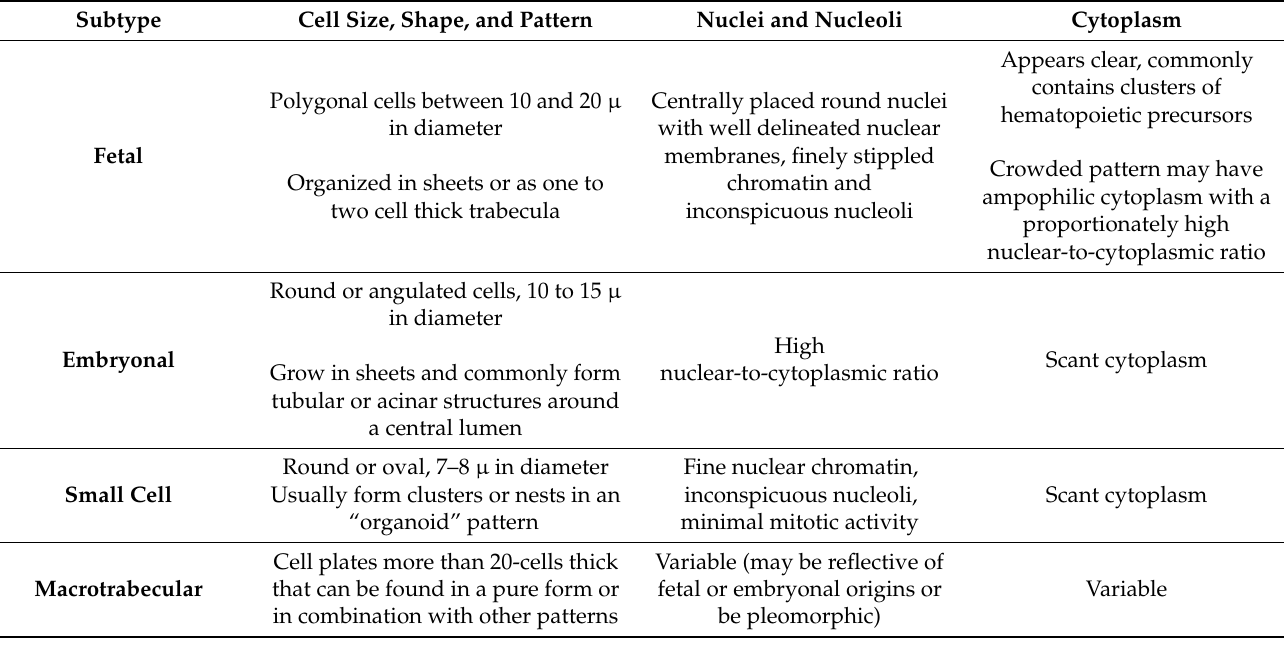
Table 2. Histopathology of Hepatoblastoma.